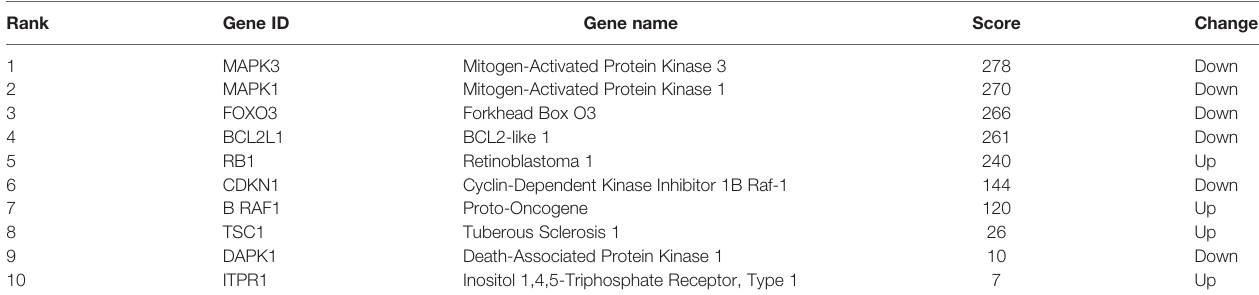
TABLE 4 | Top 10 in network ranked by MCC